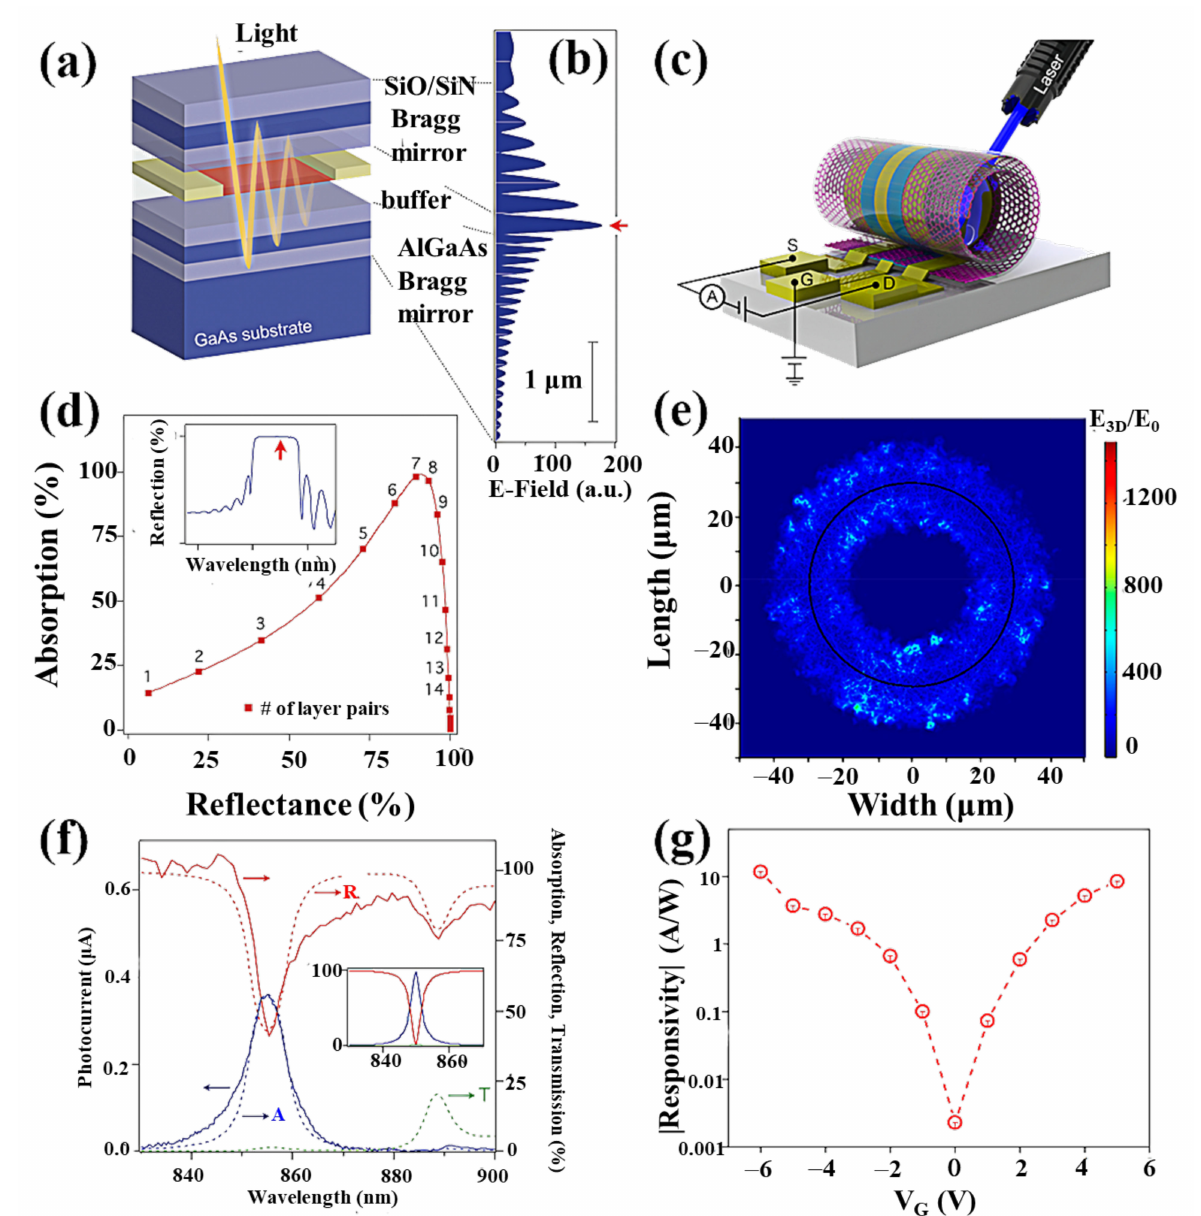
Figure 11. Optical microcavities. ( a ) Schematic drawing of a graphene microcavity photodetector. Distributed Bragg mirrors form a high-finesse optical cavity. The incident light is trapped in the cavity and passes multiple times through the graphene. ( b ) Electric field amplitude inside the cavity. ( c ) Schematic diagrams of the 3D GFETs after the roll-up. ( d ) Calculated dependence of optical absorption in a single layer graphene sheet on the reflectivity of the top mirror. ( e ) The simulated distribution of the electric field magnitude near a 3D GFET with one rolled-up winding. ( f ) Spectral response of the single-layer graphene device. The dashed lines show calculation results: reflection R ( red ), transmission T ( green ), and absorption A ( blue ). The solid lines are measurement results: reflection ( red ), photocurrent ( blue ). Inset: Theoretical result for normal incidence light. ( g ) The gate-voltage-dependent responsivity of the 3D GFETs under V DS = 0 V. Reprinted with permission from [107,148]. Copyright American Chemical Society,